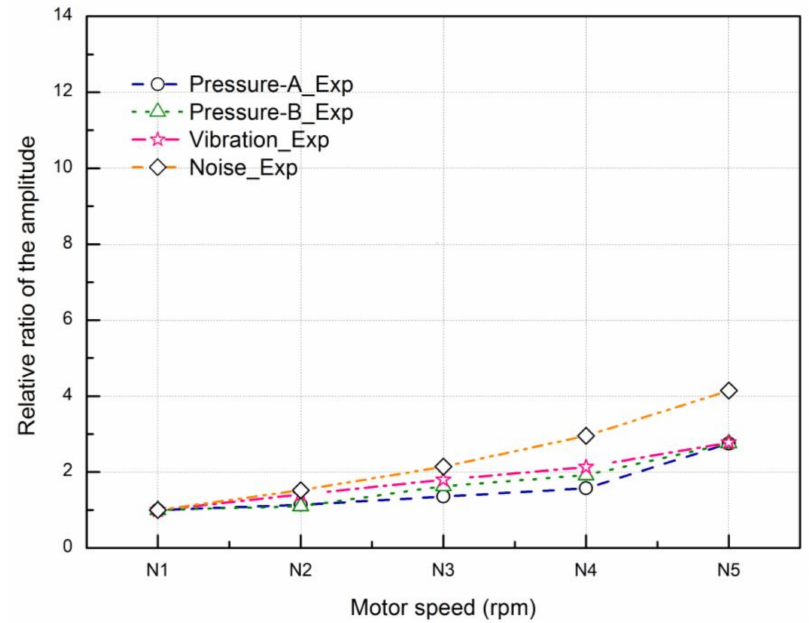
Figure 15. Comparison of the amplitudes corresponding to the primary frequencies for the Type B flapper-armature